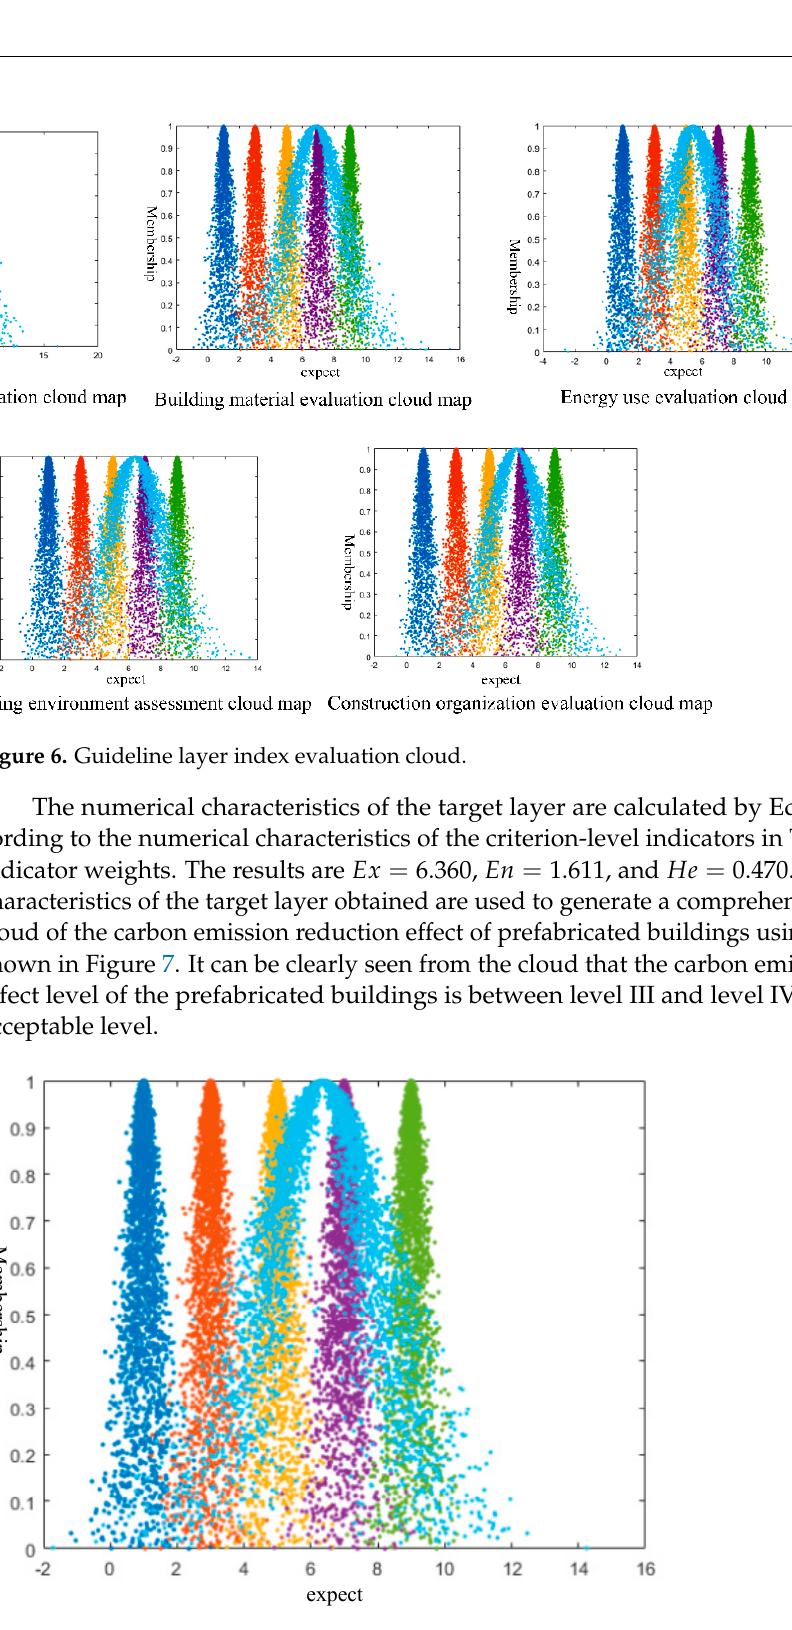
15 of 21 Table 7. Numerical characteristics of guideline level indicators. Indicators